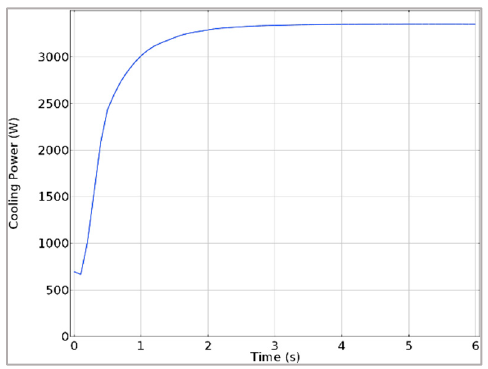
Figure 11. Cooling power—coil (copper).